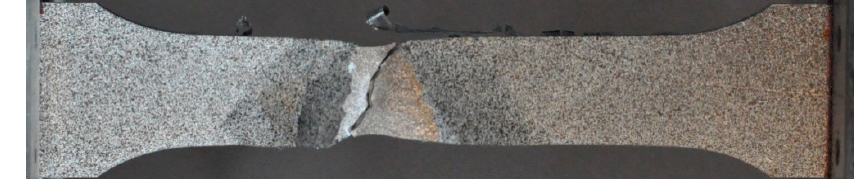
Figure 8. Photograph of sample no.1 after failure.